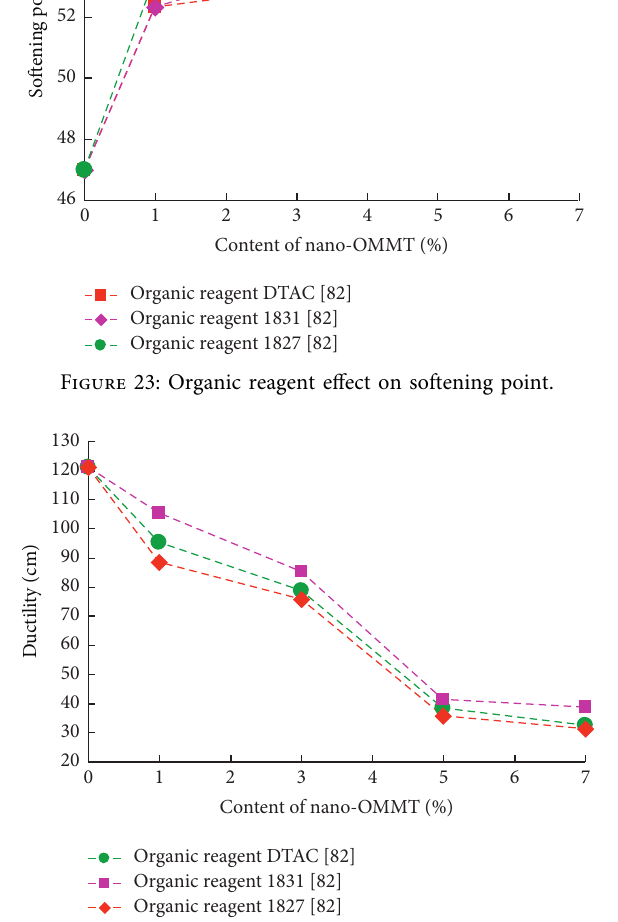
Figure 24: Organic reagent effect on